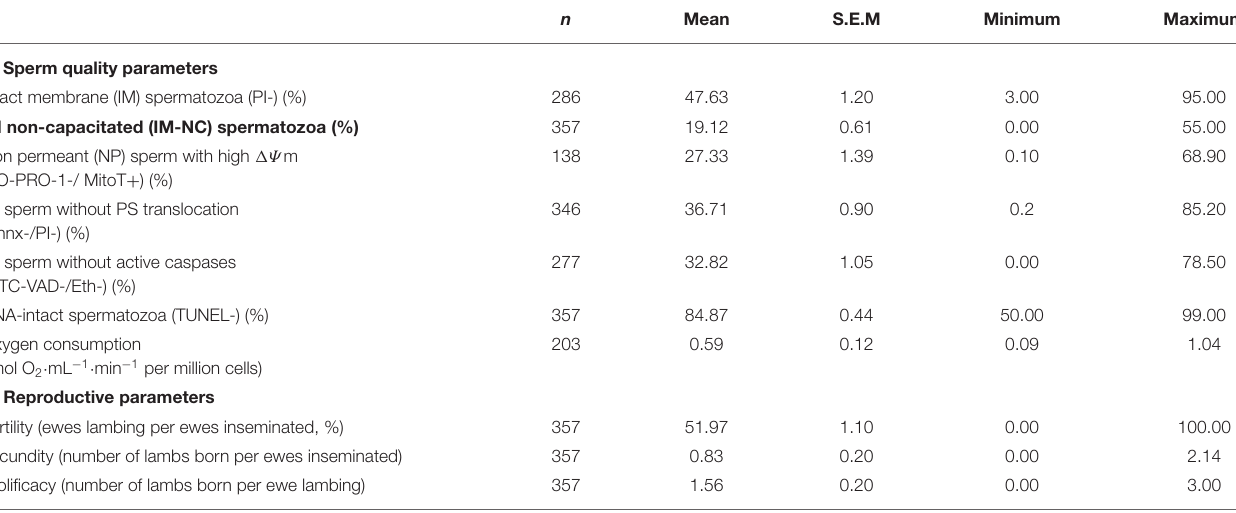
TABLE 1 | Mean, minimum and maximum values of (A) all analyzed parameters in refrigerated seminal doses, and (B) reproductive results obtained after artificial insemination with these seminal doses.